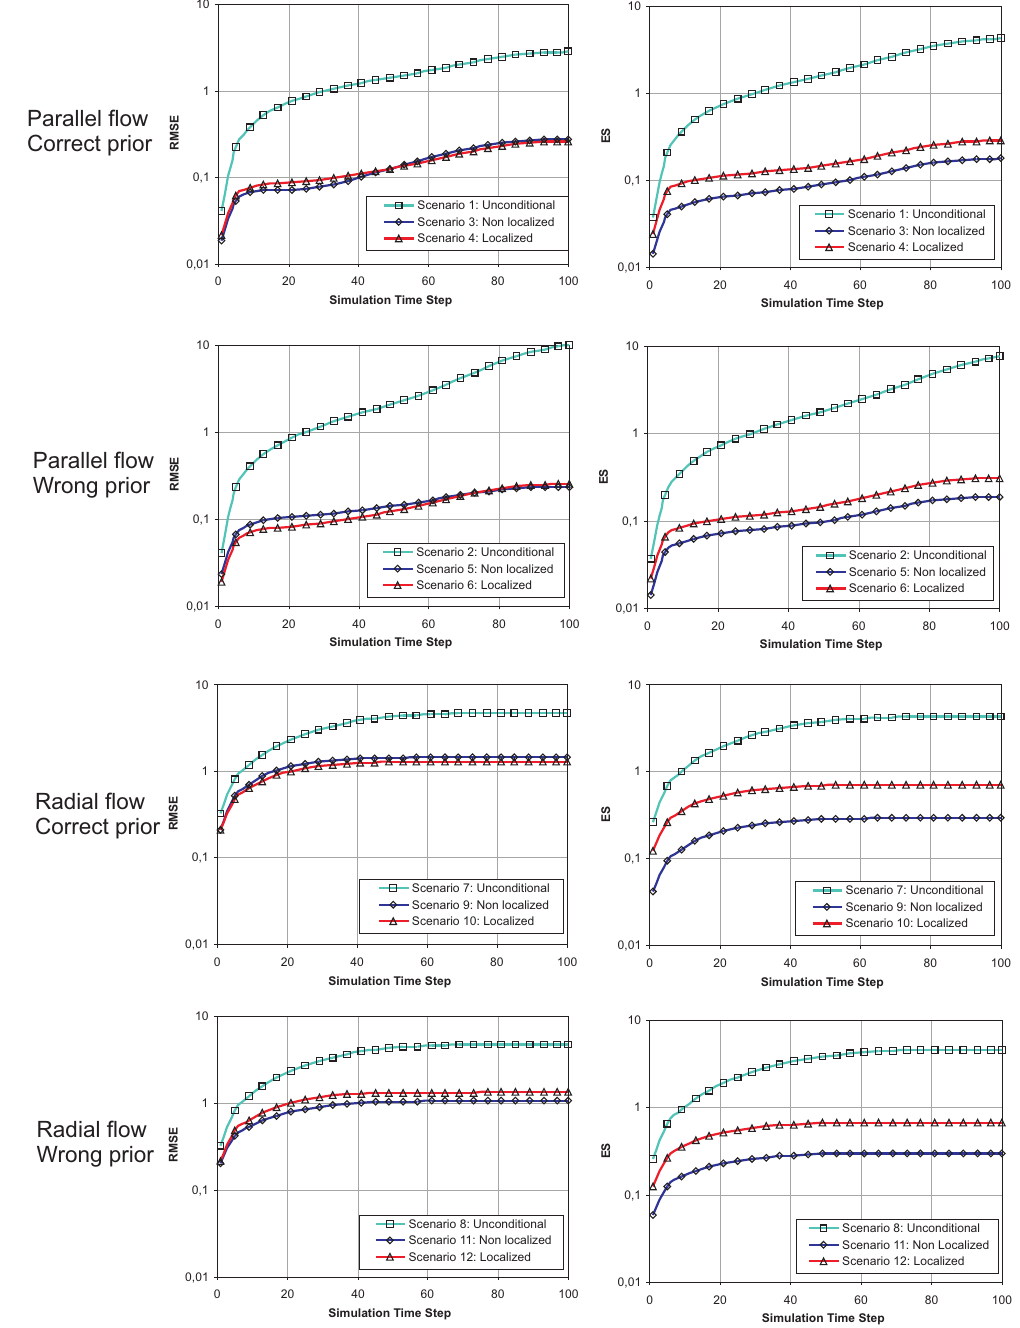
Fig. 9. RMSE and ES of simulated heads for the different scenarios. for the wrong prior random function model, assimilating the piezometric head data with the NS-EnKF, yields ensembles of realizations which, on average, capture the location of the channels in the reference field and display the highest uncer- tainty at the boundary